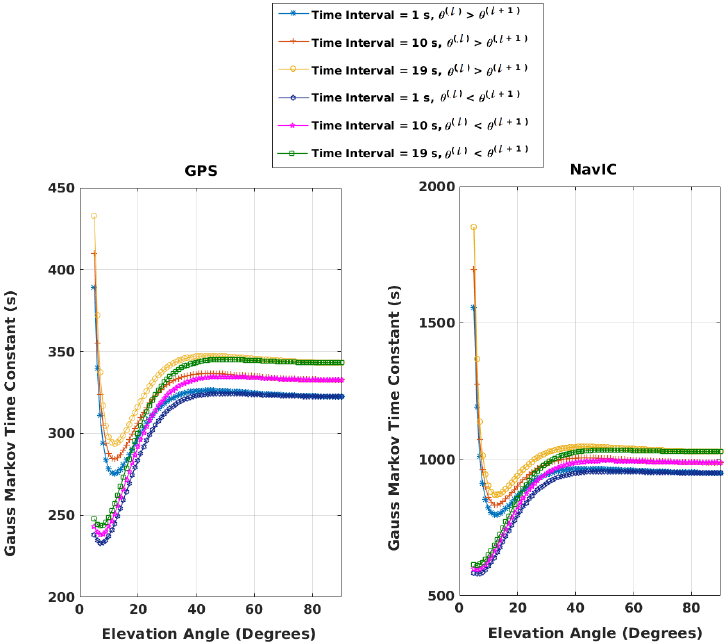
Figure 1. Equivalent time constants, 1/ β (cid:96) q as a function of θ ( (cid:96) ) ; time interval = q ∆ t ; ∆ t = 1